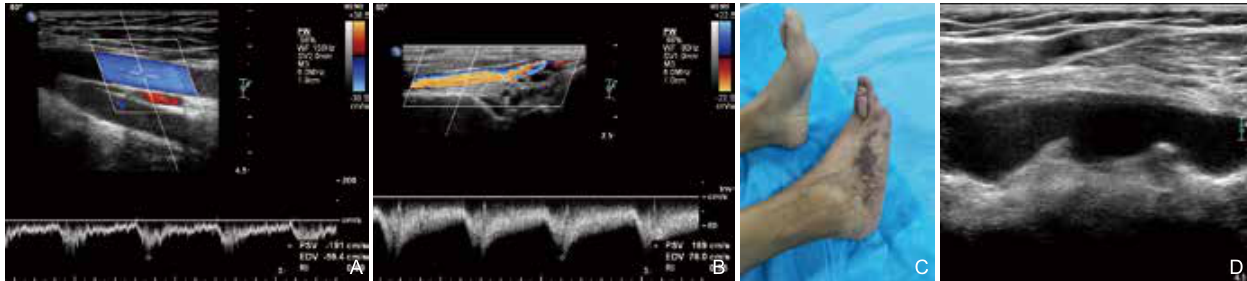
Figure 1 The superficial femoral artery (A) and anterior tibial artery (B) of the right lower limb had blood flow that was high velocity, biphasic, and unidirectional, with low resistance. The right lower limb was slightly longer than the left lower limb (C). Segments of the popliteal artery demonstrated aneurysmal dilatations (D).